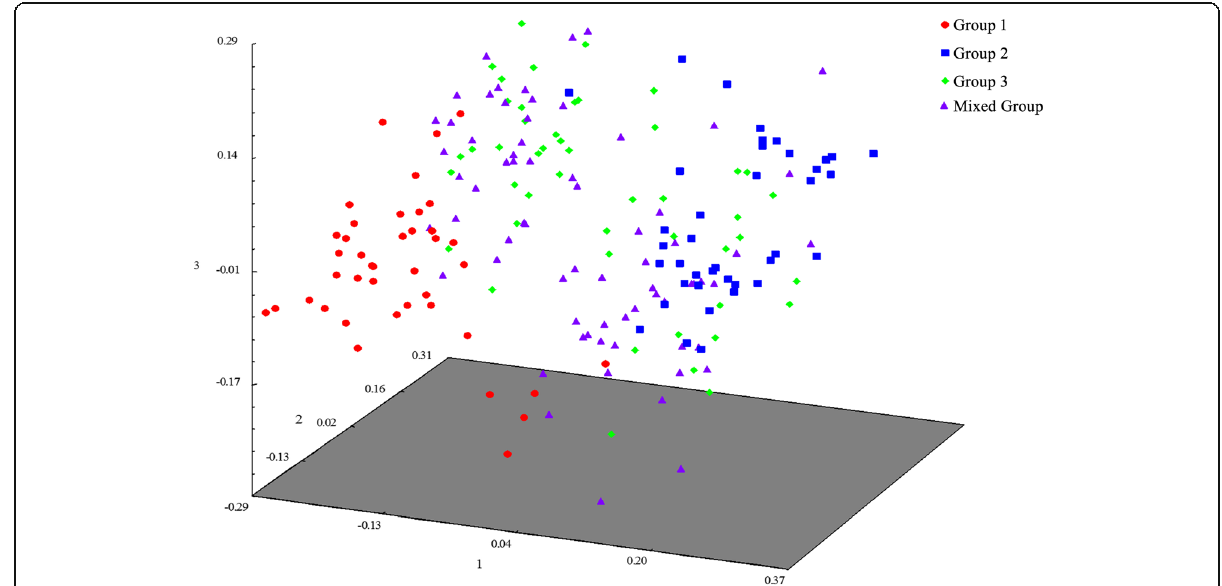
Fig. 4 Three-dimensional principal coordinate analysis of G. arboreum accessions